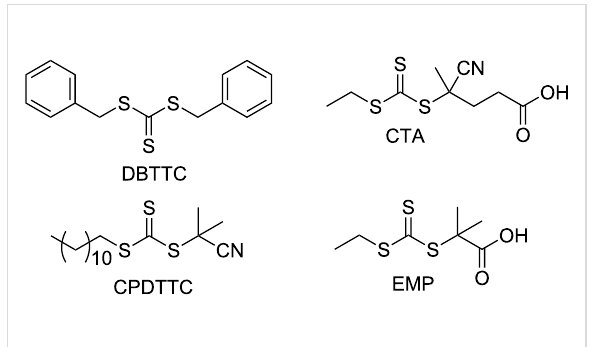
Figure 9: Structures of used RAFT agents examined in the polymeri- zation of MLA.